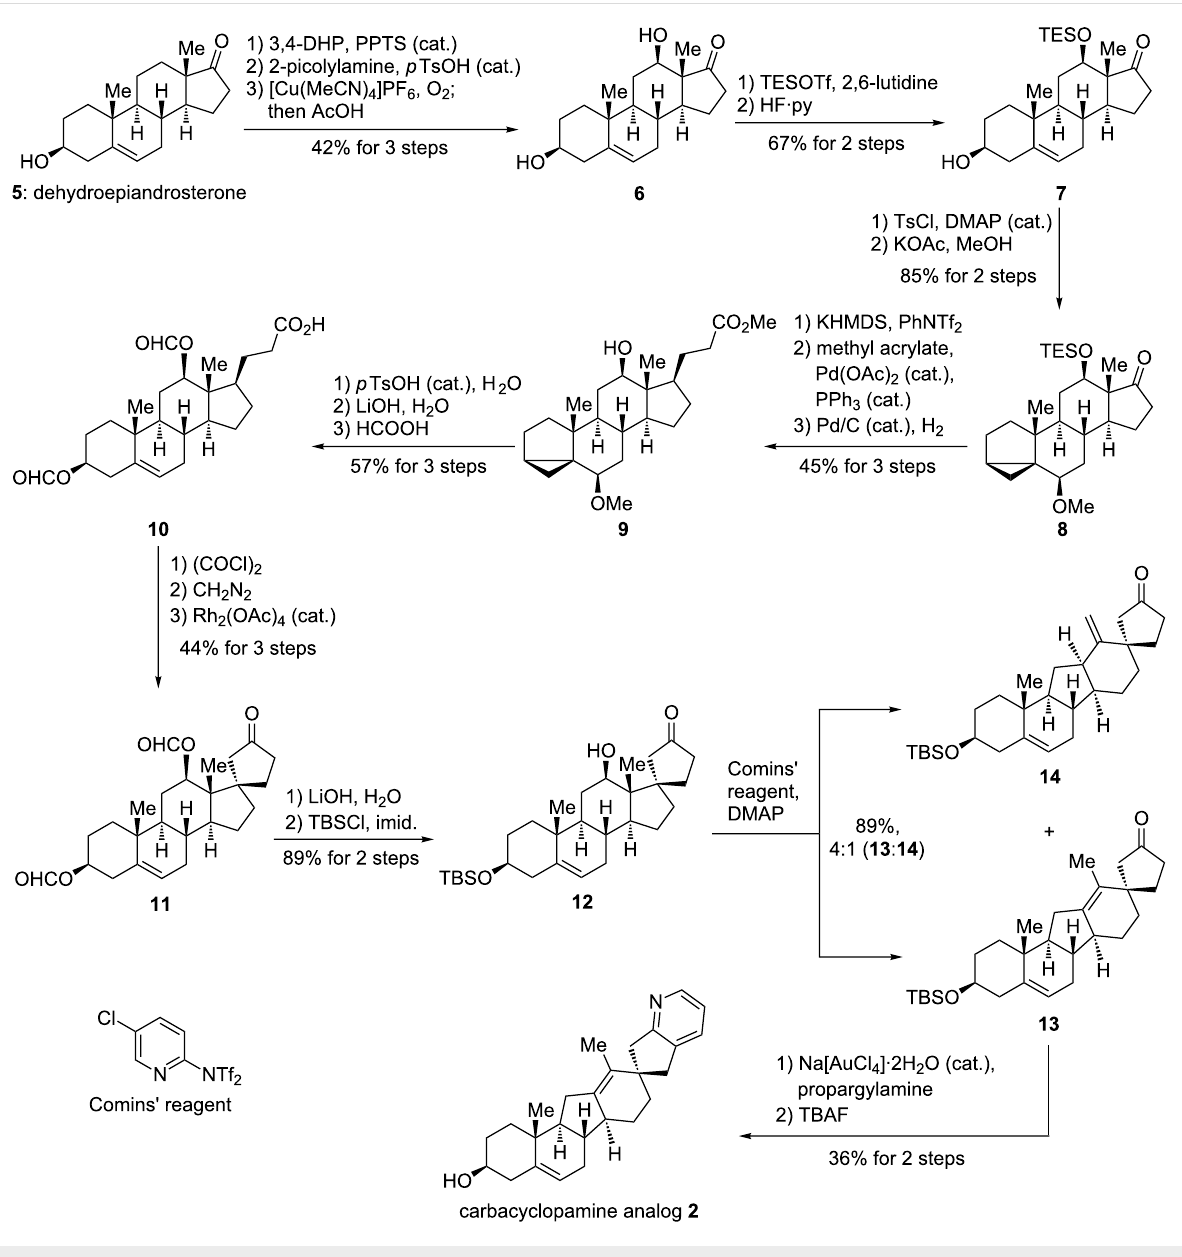
Scheme 2: Synthesis of carbacyclopamine analog 2 .